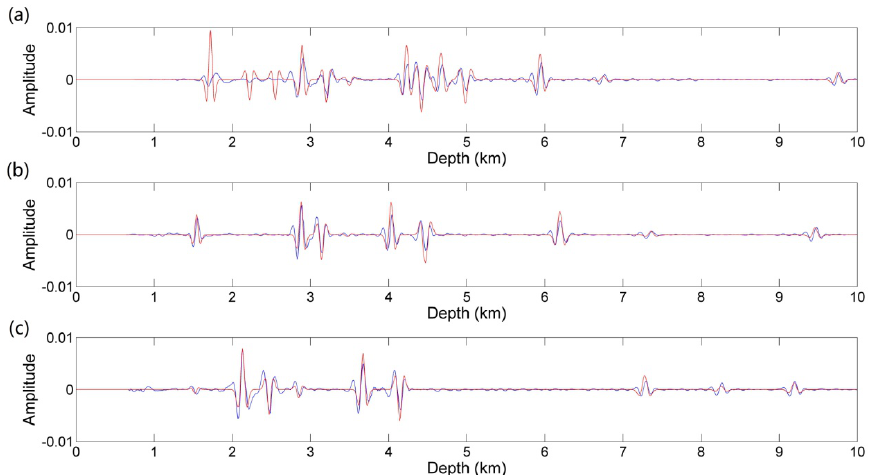
Figure 12. The imaging result of our proposed method.